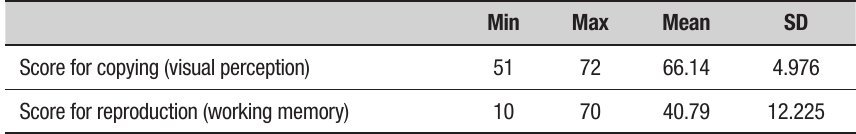
Table 2. Descriptive statistics of visual perception and working memory.